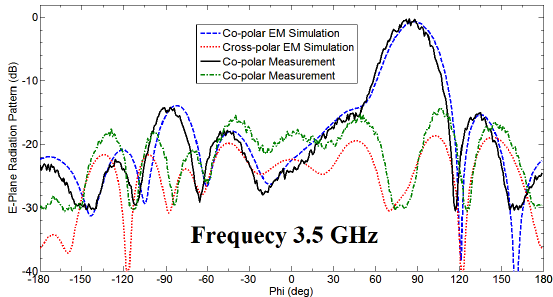
Figure 7. Normalized E-plane pattern of the developed antenna array having fan beam at 3.50 GHz.